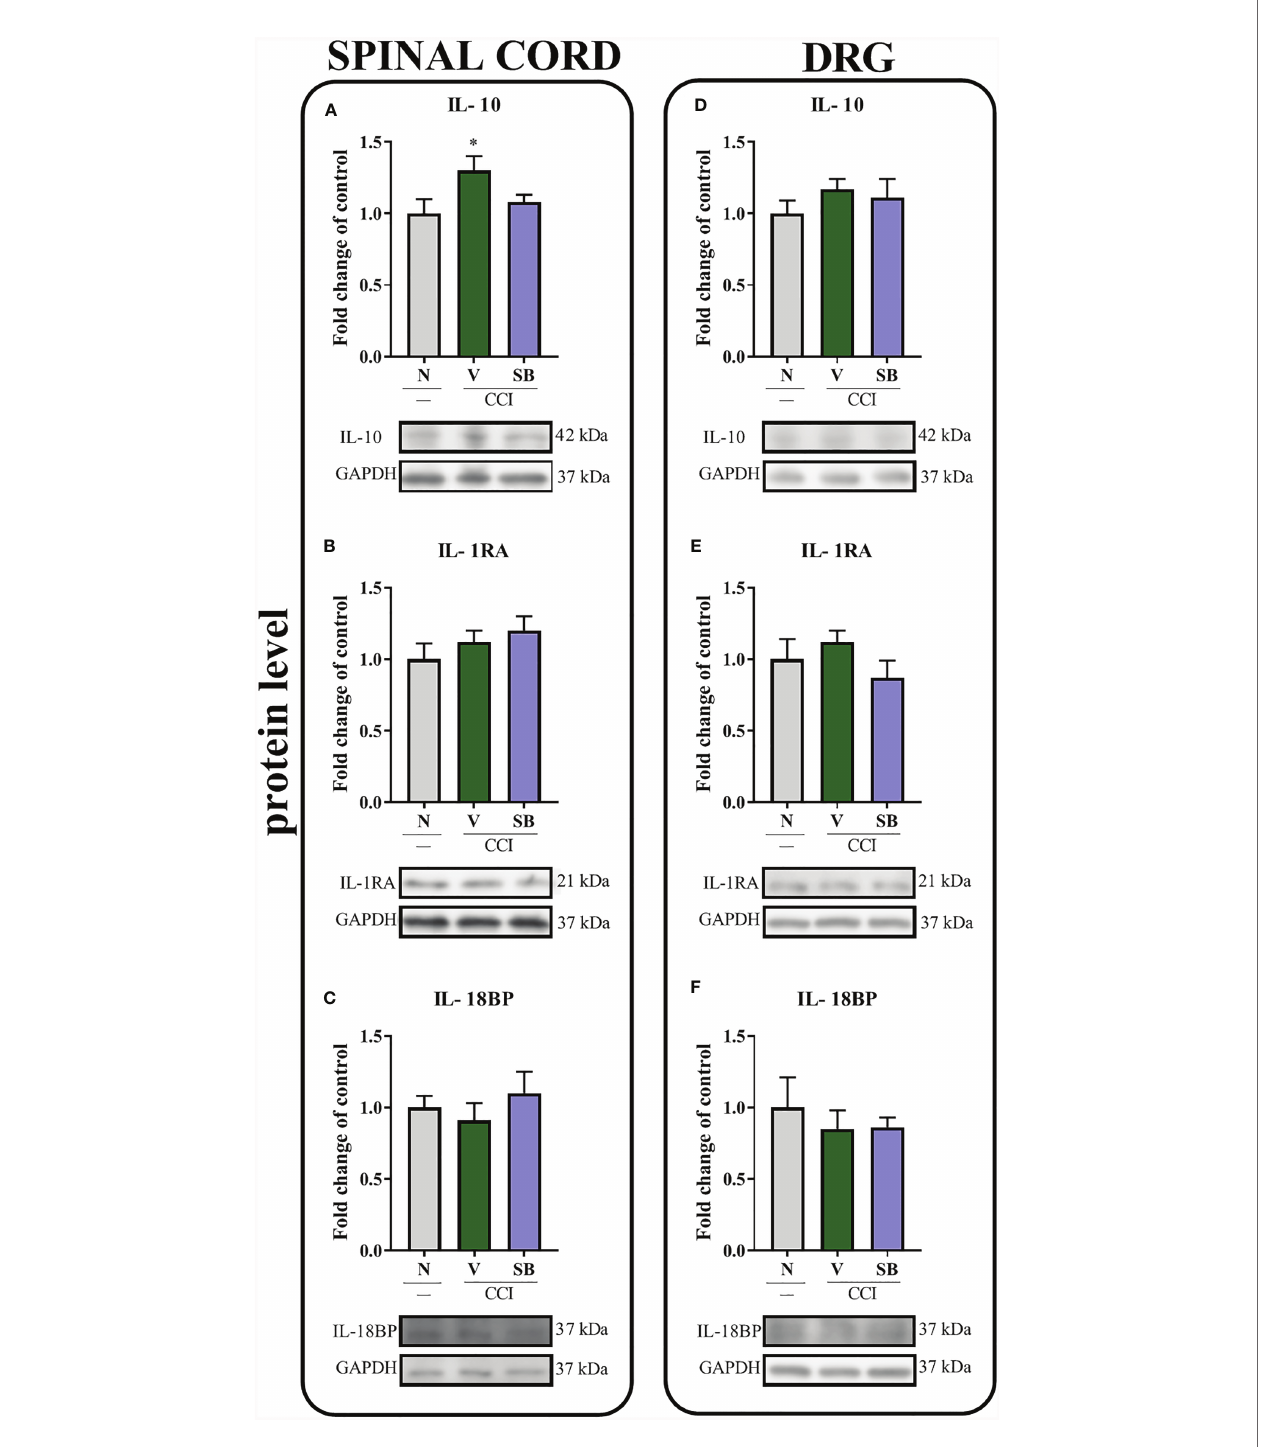
FIGURE 6 | Effects of repeated administration of SB328437 (SB, 10 m g/5 m l; i.t .); 16 h and 1 h before chronic constriction injury of the sciatic nerve (CCI) and then once a day for 7 days on levels of the IL- 10 (A, D) , IL- 1RA (B, E) and IL-18BP (C, F) proteins in the rat spinal cord (A – C) and the DRG (D – F) on the 7 th day post- CCI. The data are presented as the mean fold changes relative to the control ± SEM (6 – 8 samples per group). Intergroup differences were analyzed using ANOVA with Bonferroni ’ s post hoc test for multiple comparisons. *P < 0.05 indicates a signi fi cant difference compared with the control group (naive, N rats). No differences were measured compared to Vehicle (V)